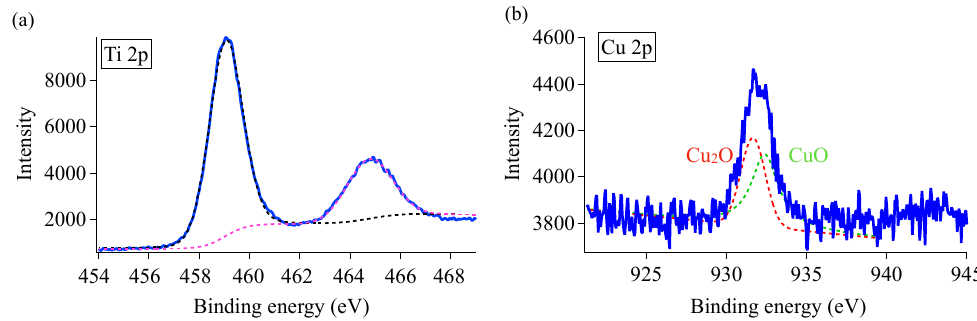
Figure 13. XPS spectra of Cu-doped TiO 2 prepared with 10 mM Cu nitrate. ( a , b ) Narrow scans for Ti 2p and Cu 2p, respectively. ( b ) Green, red, and gray lines indicate Cu 2 O, CuO, and Cu(NO 3 ) 2 ,